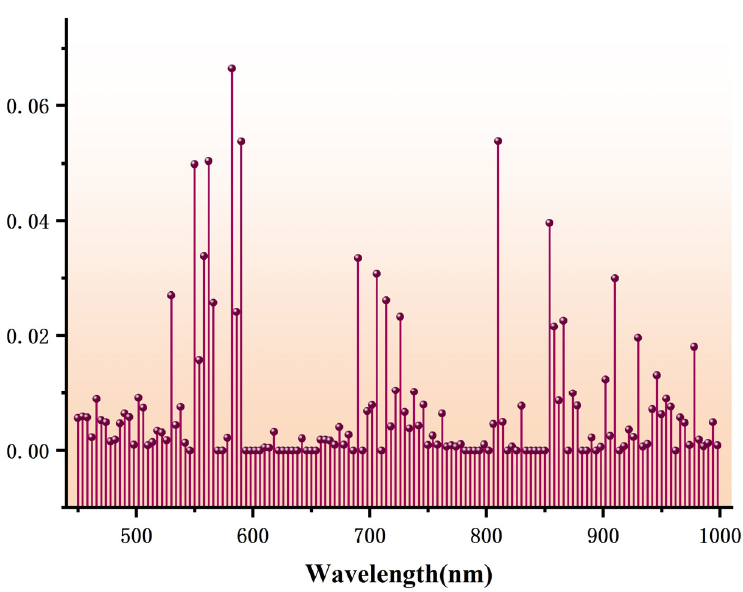
Figure 11. XGBoost contribution rate evaluation results of the SSR data.